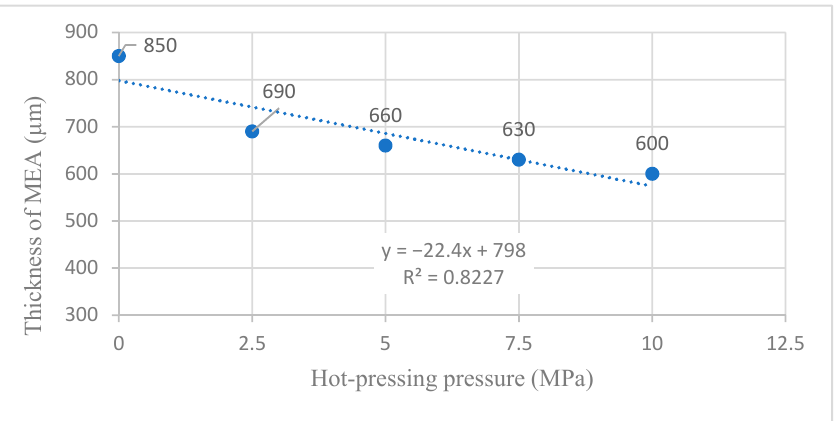
Figure 17. The fitting curve of the thickness of MEA at different hot-pressing pressures.